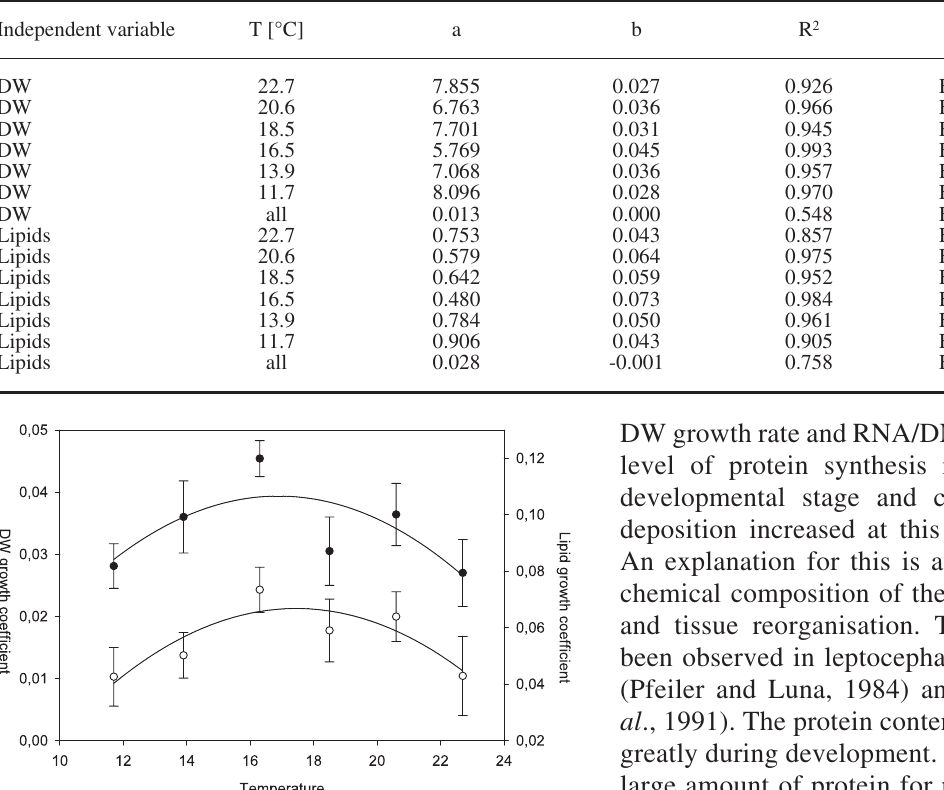
T ABLE 4. – Parameter estimates, R 2 , degrees of freedom (DF) and p value for exponential growth [f=a*exp(b*x)] in dry weight (DW) and lipids (L) over 6 different temperatures (T) (Fig. 5), along with the overall dome-shaped relationship over all temperatures from Fig.